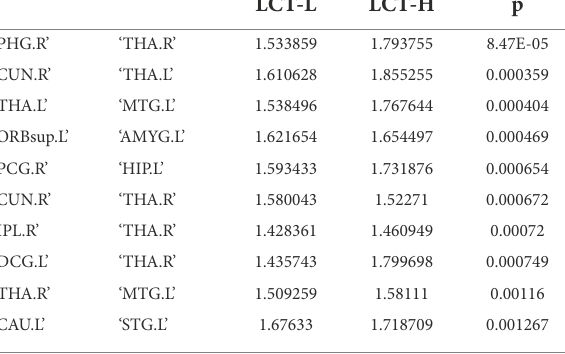
TABLE 3 Consensus connections.